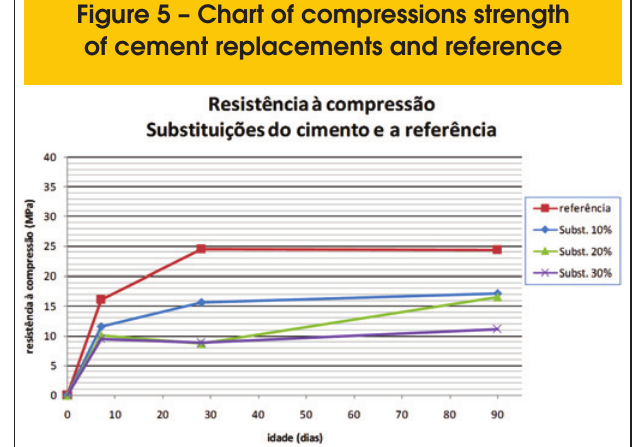
Figure 5 – Chart of compressions strength of cement replacements and